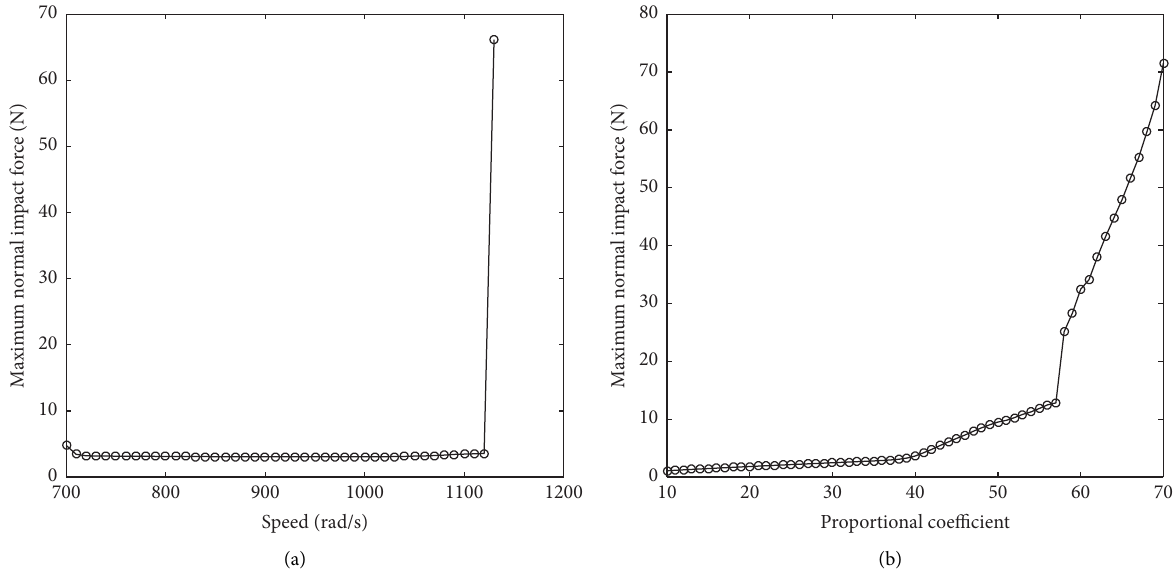
Figure 21: Maximum normal impact forces of the MSDS with K